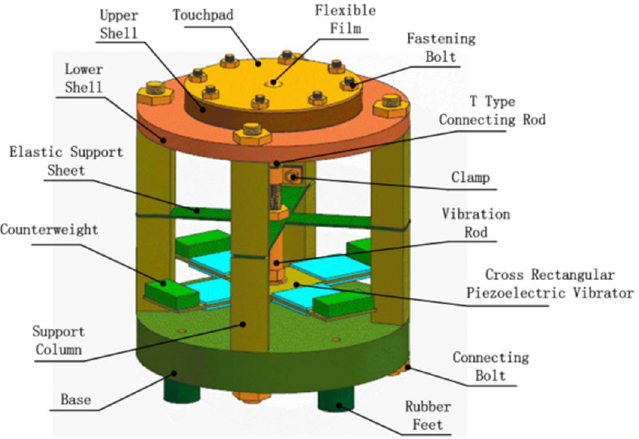
Figure 1. Structural illustration of flexible convex device.